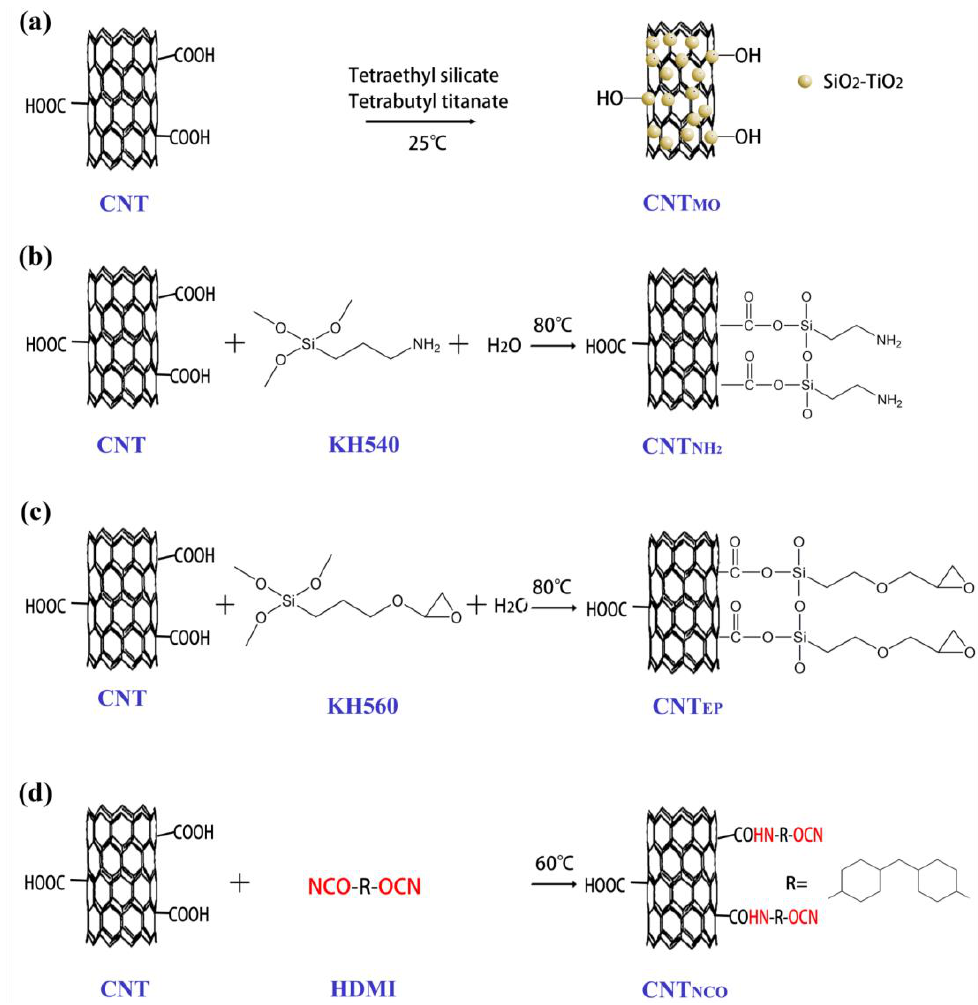
Figure 4. Scheme of surface changes of modified CNT . ( a ) CNT MO ; ( b ) CNT NH2 ; ( c ) CNT EP ; ( d ) CNT NCO .